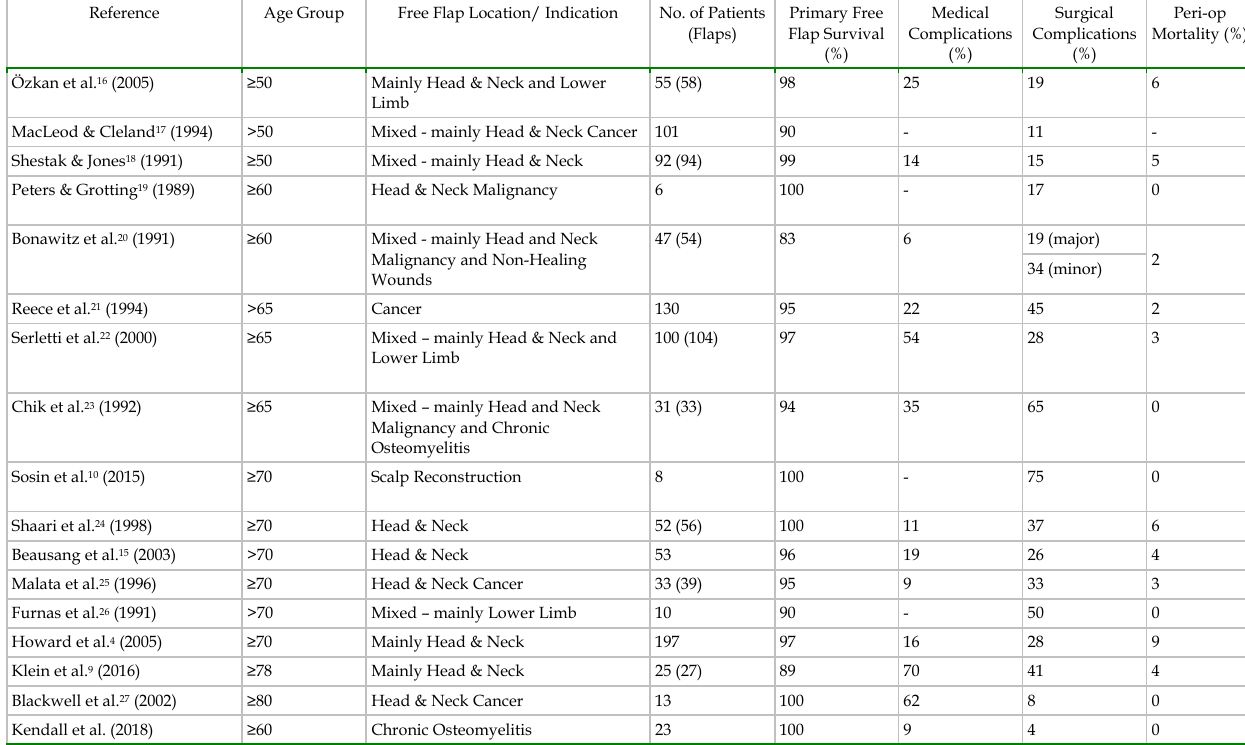
Table 6 : Review of published series of free flap transfers in older patients.